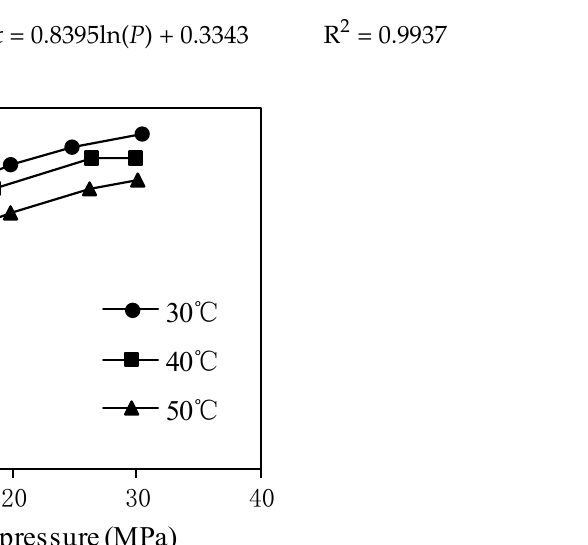
11 of 17 Figure 8. Constant Z versus equilibrium pressure at different temperature. 4.4. Effect of Temperature on Adsorption Rate Constant The plot of the adsorption rate constant versus equilibrium pressure at 30, 40 and 50 °C is shown in Figure 9 to illustrate the temperature effect on the adsorption dynamic of methane molecules on shale powders. Obviously, it is shown that the adsorption rate con-